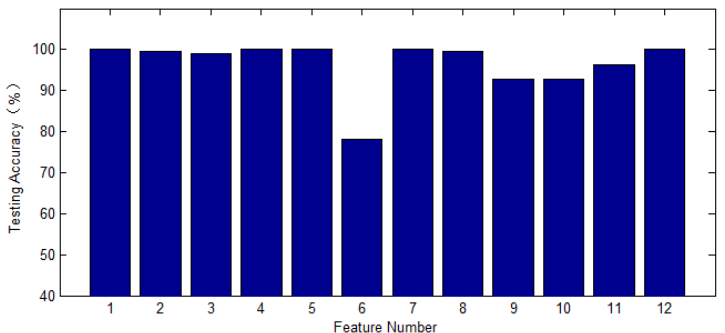
Figure 16. Diagnosis result of fault severity of inner race under different features. 1: Ma ; 2: Mi ; 3: P k ;